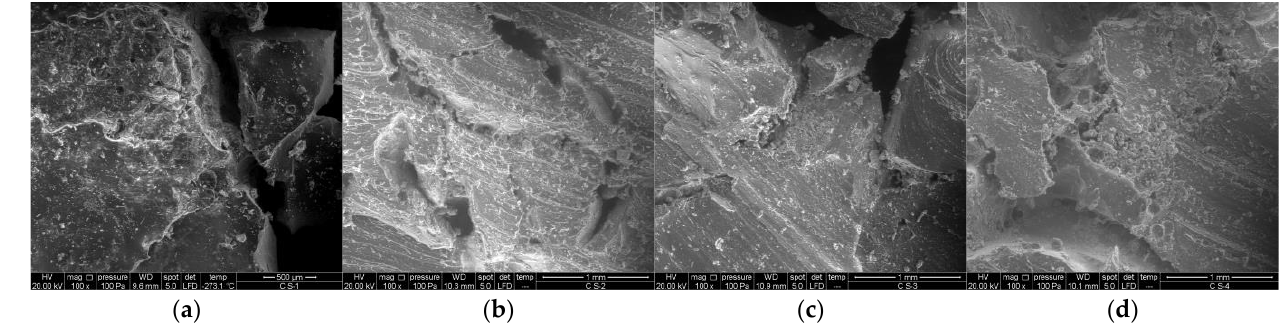
Figure 12. Morphology of a red rubber substrate with an immobilized 2 g of TiO2 through three horizontal layers (100×): ( a ) surface; ( b ) first layer (2 mm); ( c ) second layer (4 mm); and ( d ) third layer (6 mm).